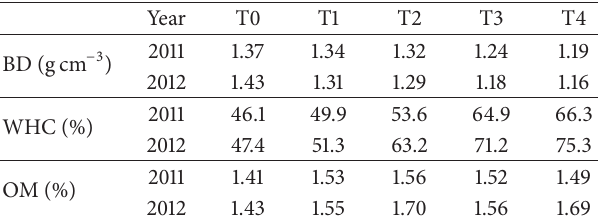
Table 7: Treatment effect on surface soil (0–10cm depth) BD (bulk density), WHC (water holding capacity), and OM (organic matter) in 2011 and